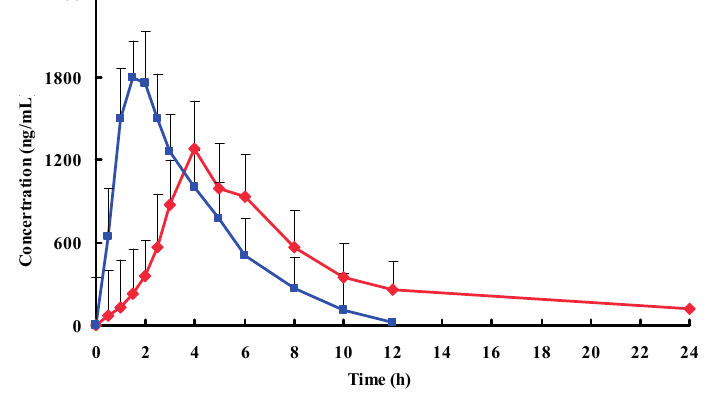
Figure 3. Mean plasma concentration-time profiles of PPF after oral administration of a single 20 mg/kg dose of pellets (red) and tablets (blue) to beagle dogs (each point represents the mean ± standard deviation (SD) of 6